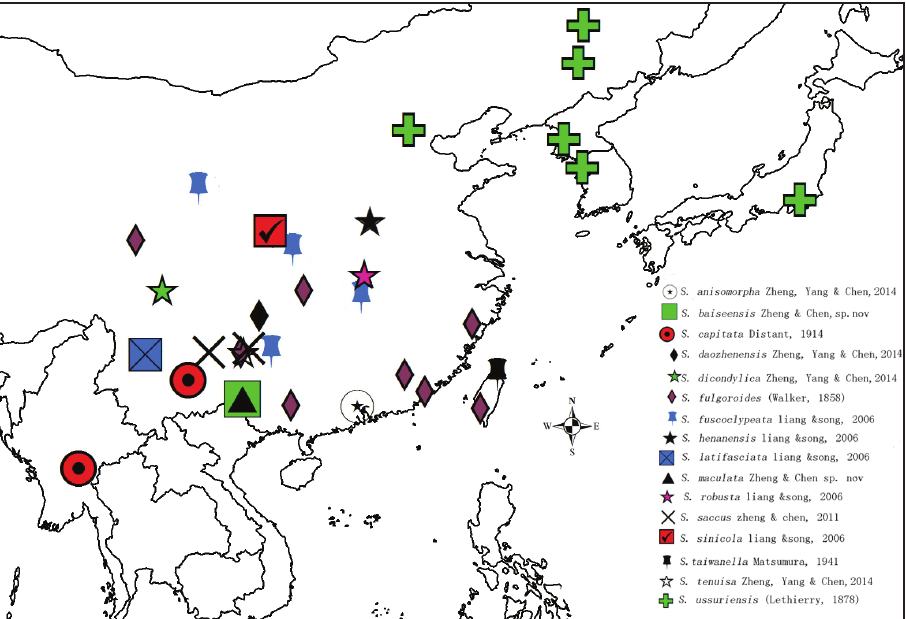
Figure 32. Geographical distribution of the genus Saigona